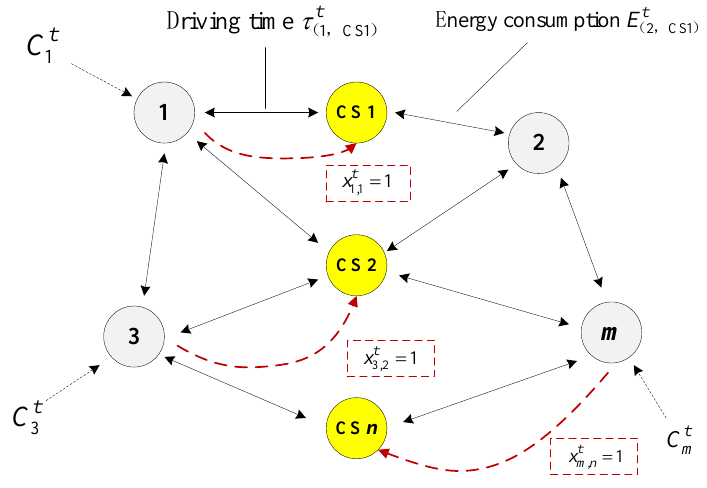
Figure 2. Stochastic route guidance problem in a time-varying road